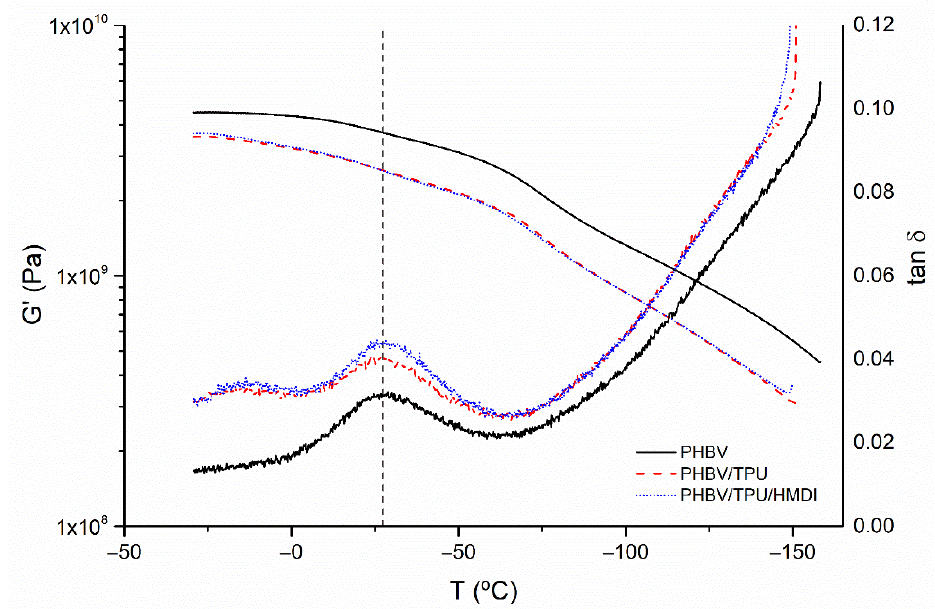
Figure 4. The storage modulus (G ′ ) and tan δ evolution with temperature for the neat PHBV and PHB/TPU blends.